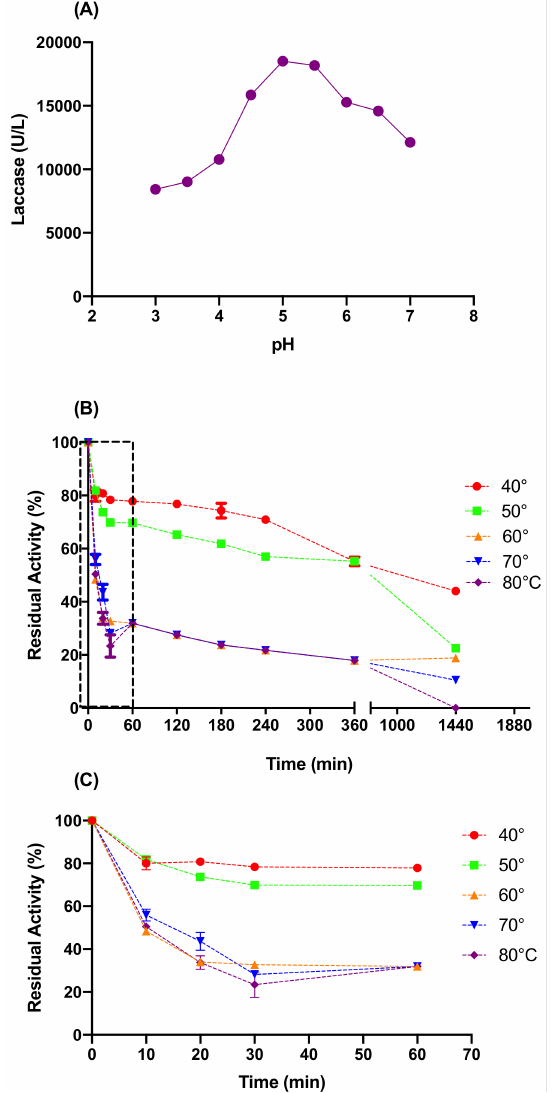
Figure 2. Optimum pH for catalytic activity ( A ) and thermal stability of L. sajor-caju crude laccase in longer times ( B ) and extension of shorter times ( C ). The buffer solutions for optimum pH assay were used according to their buffer range: Sodium Acetate (3–5) and Sodium Phosphate